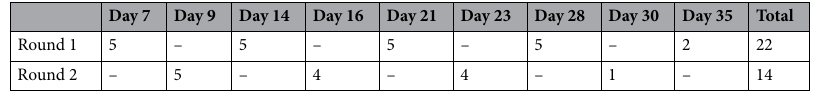
Table 1. Sample size of mice per imaging day based on protocol tumor size endpoints.